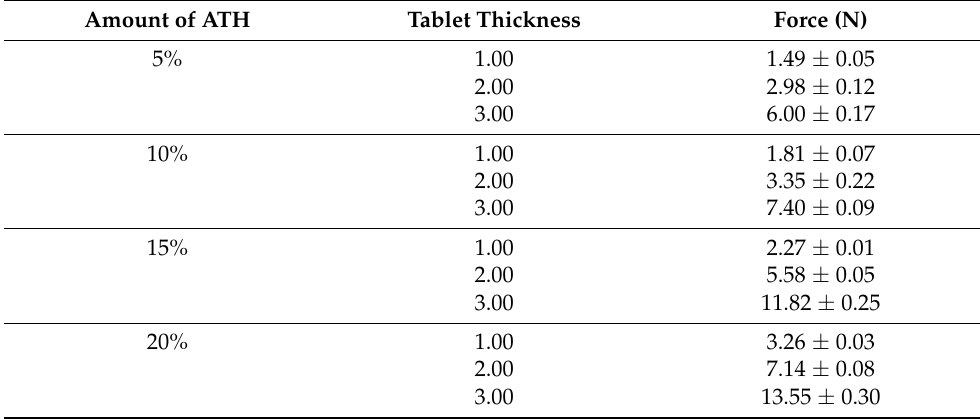
Table 2. Measured force in the test with needle probe (mean ± SD). Amount of